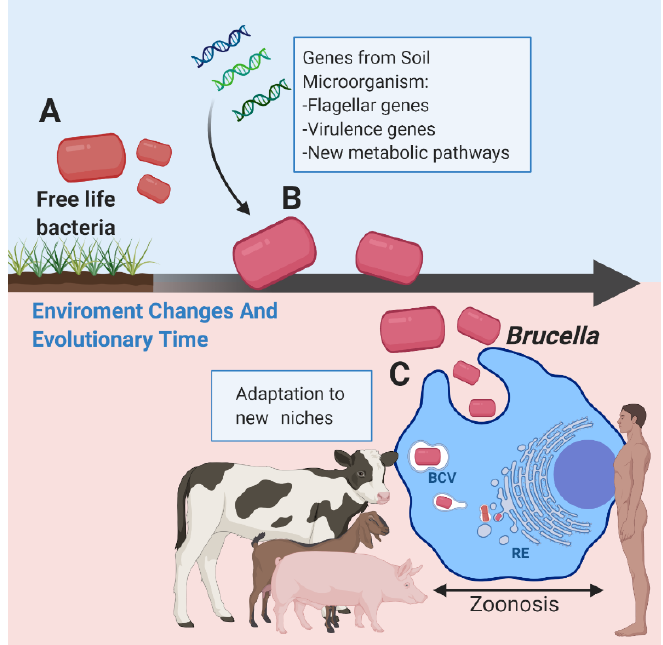
Figure 5. (A) In terms of its evolutionary origin, it is postulated that Brucella may have been a free- living bacterium. (B) Over time, and according to its evolution, it remained in contact with other microorganisms, such as soil bacteria and fungi, managing to acquire certain genes that, therefore, improved its metabolic resources. (C) Environmental changes helped give it the ability to adapt to new hosts, such as eukaryotic cells. In Brucella , certain virulence factors that are different from other bacteria, like its LPS, its type-four secretion system (T4SS) and the BvrR/BvrS system, enable Brucella to interact with the host cell surface and form an early Brucella -containing vacuole (BCV) for its subsequent interaction with the endoplasmic reticulum (ER), where bacteria multiply and reach their replicative niche. Likewise, the presence of flagellar genes and the active participation of fla-